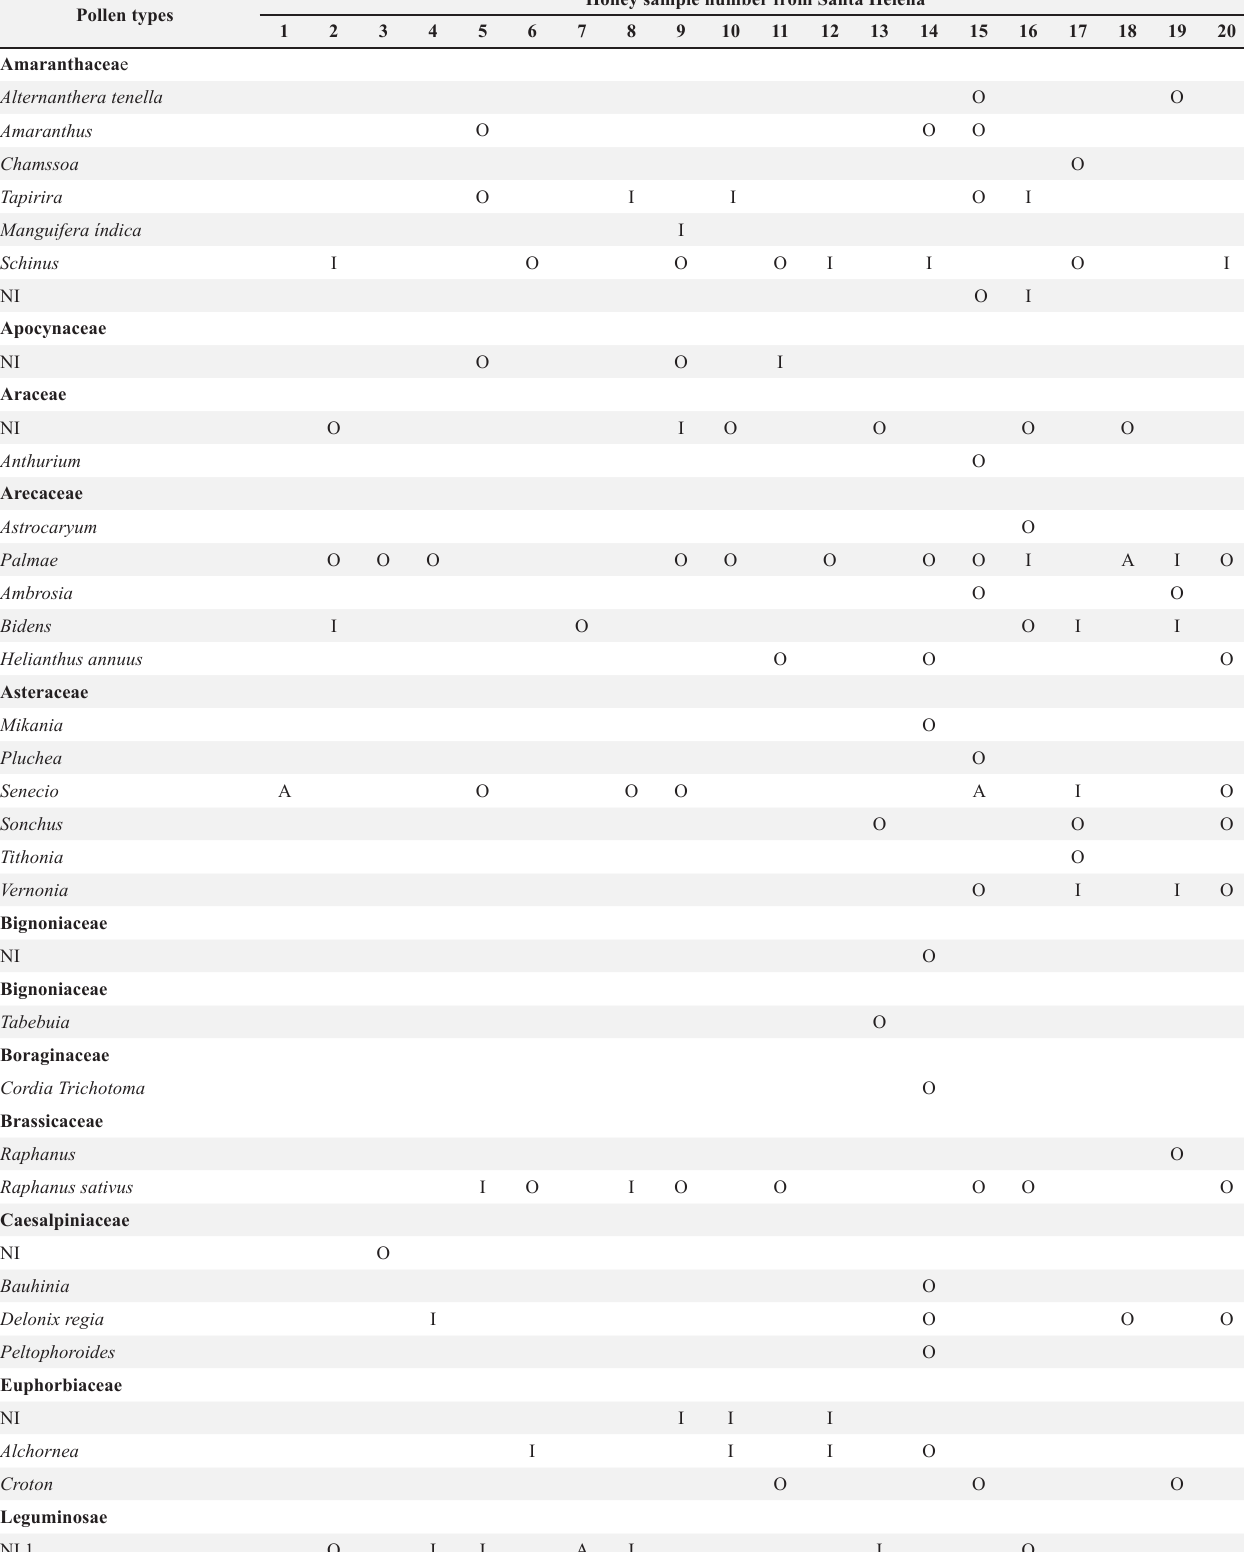
Table 1. Pollen types and frequency classes of: Santa Helena honey samples, where: D: dominant pollen (> 45%); A: accessory pollen